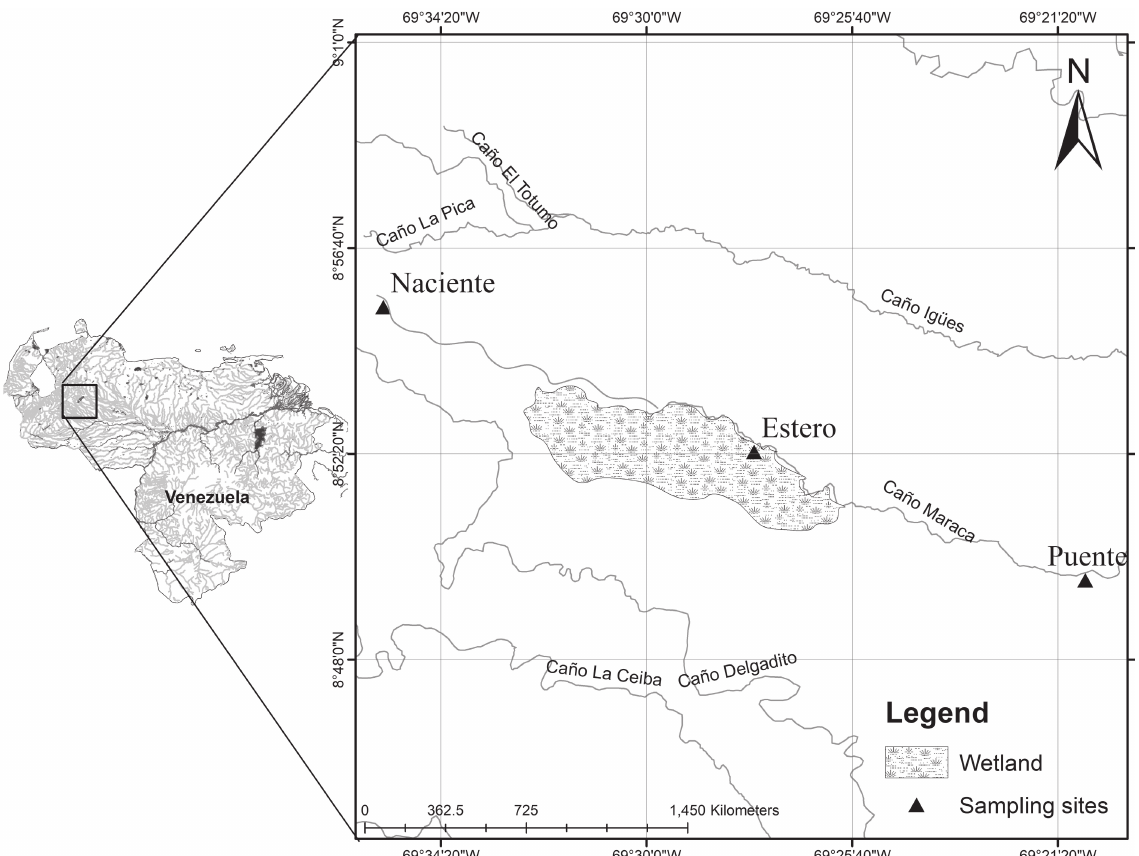
Fig. 1. Map showing location of Caño Maraca within the Orinoco River Basin in Venezuela and locations of three survey sites (triangles).